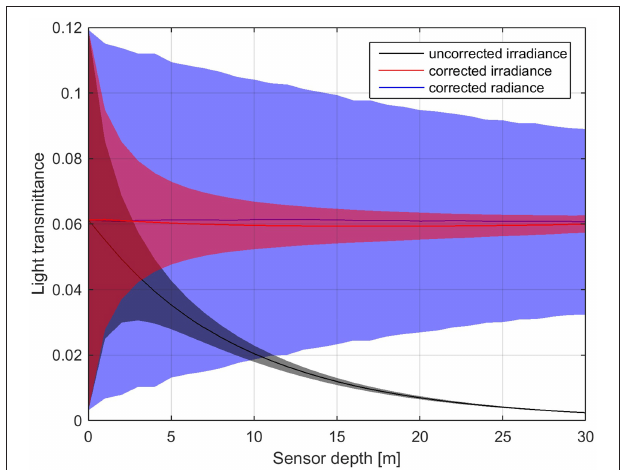
FIGURE 10 | Mean (solid lines) and standard deviation (colored area) of light transmittance over sensor depth for uncorrected irradiance (black), depth corrected irradiance (red), and depth corrected radiance data